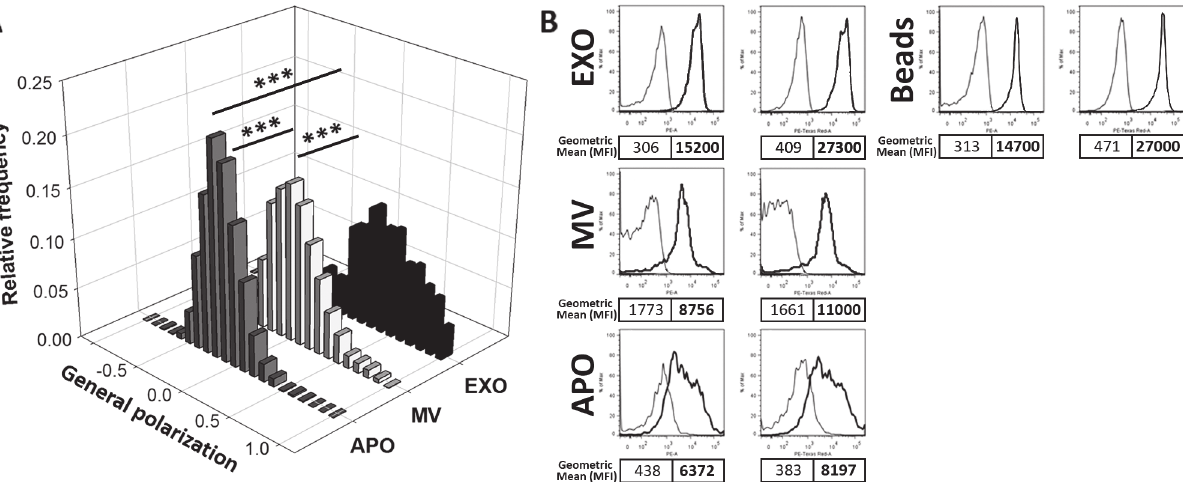
Fig 5. Spectral ratiometric determination of EV membrane lipid order. A shows the quantitative assessment of membrane lipid order in subpopulations of EVs secreted by BV-2 cells is shown ( (cid:3) 3 independent experiments each EV type). Ratiometric measurements of the fluorescent intensities at 560 – 600nm and at > 660nm were carried out by confocal microscopy, and results are expressed as general polarization (GP) values. The higher GP value reflects a higher membrane lipid order. EXOs showed the highest order, while APOs and MVs were characterized by partially overlapping, intermediate order. B shows the flow cytometric determination of di-4-ANEPPDHQ staining of EV subpopulations secreted by BV-2 cells. Representative results of one out of n = 3 independent experiments. Left panels represent the fluorescence at 585 ± 21 nm, while right panels represent fluorescence at 616 ± 12 nm of unstained and stained vesicles and beads (thin and thick lines, respectively). Geometric mean fluorescent intensities (MFI) of unstained and stained APOs, MVs, EXOs coupled to latex beads, and beads without EXOs are shown (regular and bold text, respectively).